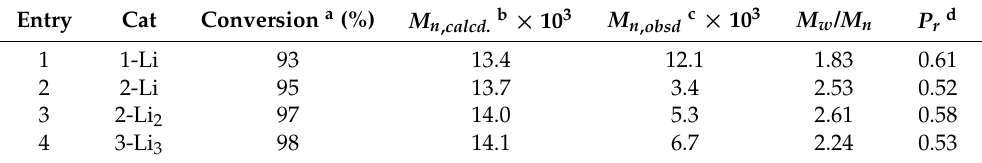
ROP of rac -lactide ( rac -LA) catalyzed by lithium complexes. Cat = catalyst, P r = heterotactic